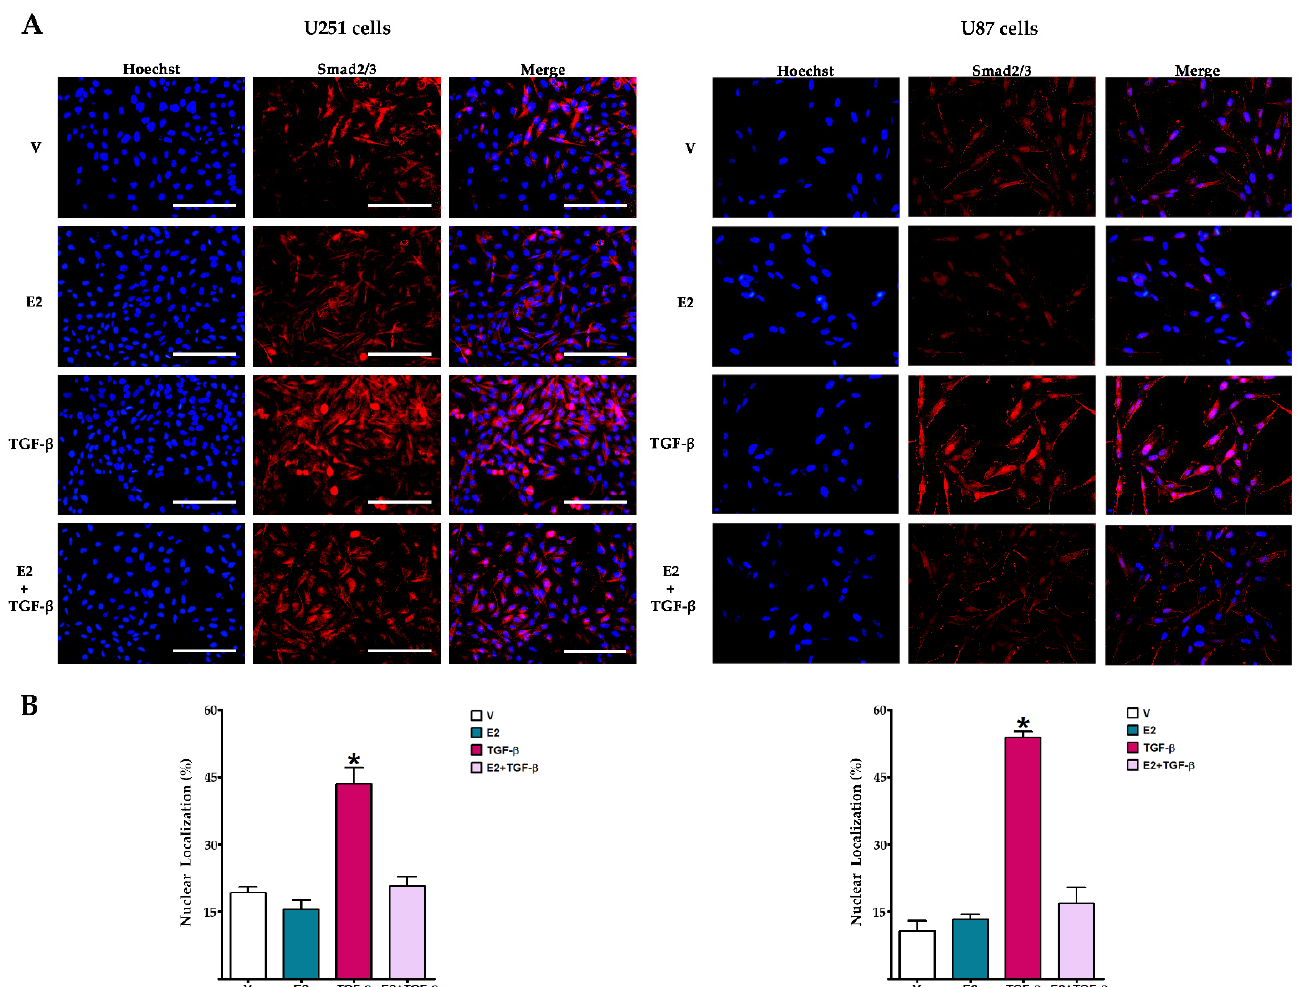
Figure 3. E2 effect on TGF- β -promoted nuclear translocation of Smad2/3 complex in human GBM-derived cells. ( A ) Smad2/3 immunostaining in U251 and U87 cells treated with vehicle (V, 0.01% cyclodextrin + 0.0001% BSA), E2 (10 nM), TGF- β (10 ng/mL) and E2 + TGF- β for 48 h. Scale white bars = 100 µm. ( B ) Nuclear colocalization of Smad2/3 complex. The percentage of nuclear colocalization was calculated considering the number of Hoechst-stained cells using the Cell Counter plugin in ImageJ software. Results are expressed as the mean ± standard error of the mean (SEM); n = 3; * p < 0.05 vs. all other groups.